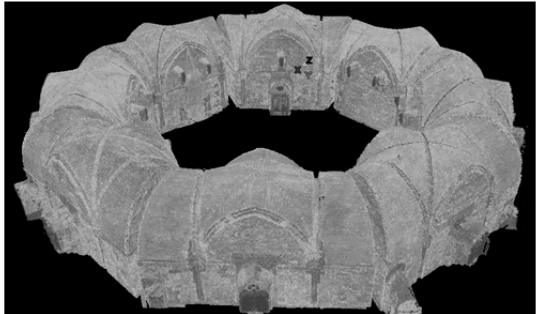
Figure 7. Assembly of the ground floor point clouds